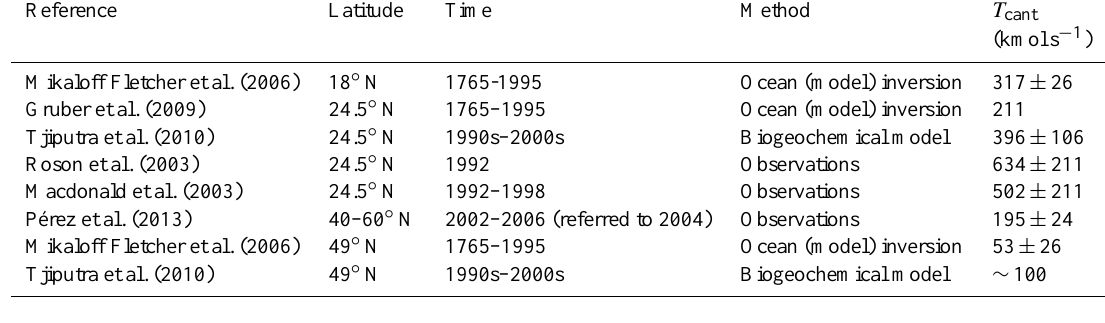
Table 1. Estimations of transport of Cant ( T cant ) in the North Atlantic from the literature. T cant is often given in PgCyr − 1 (1PgCyr − 1 =2642kmols − 1 ).